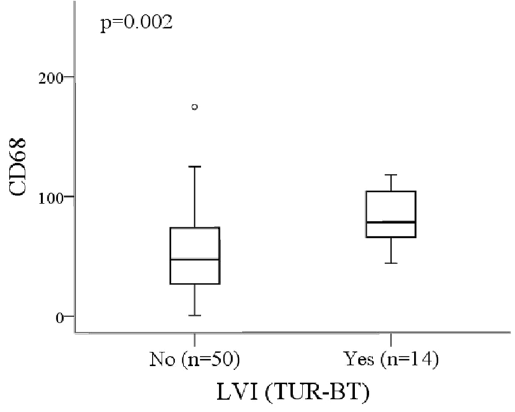
Figure 2. High CD68 + macrophage counts associate with the presence of LVI (Mann-Whitney U test).